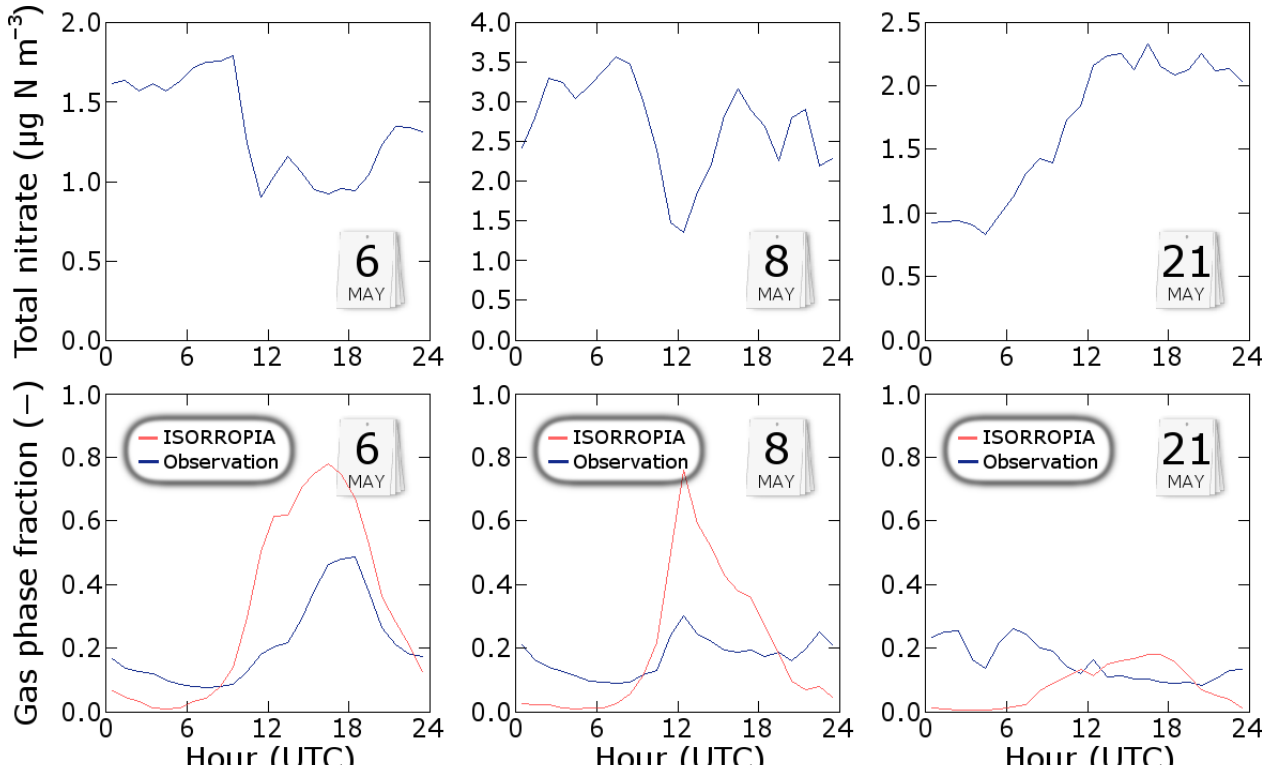
Fig. 2. Upper panels: observed total nitrate (nitric acid plus aerosol nitrate) concentration at Cabauw for 6 May (left), 8 May (middle) and 21 May (right). Lower panels: observed partitioning of nitrate and equilibrium by ISORROPIA for these